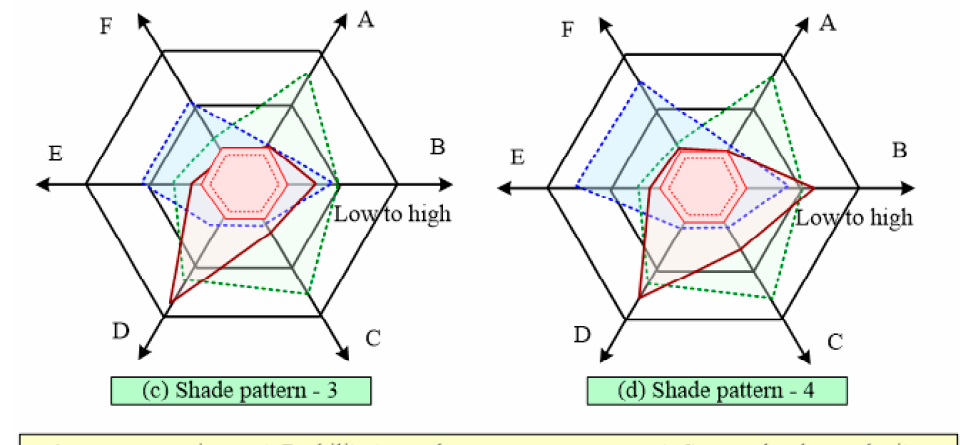
Figure 9. Wheel chart representation of various performance indices for shade patterns (1–4).